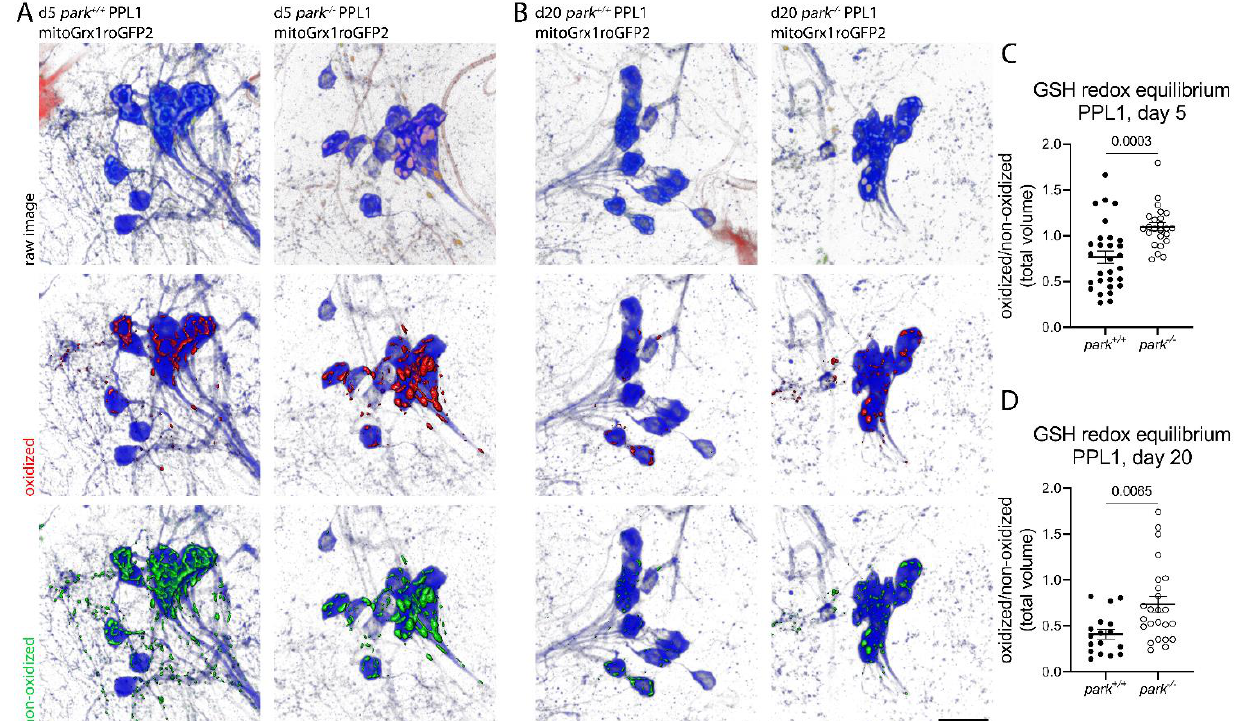
Figure 2. Parkin-null Drosophila have increased PPL1 mitochondrial glutathione redox equilibrium. Brains were dissected from control ( park +/+ ) or parkin-null ( park −/− ) flies expressing mito-roGFP2-Grx1 on days 5 and 20 post-eclosion, and ratios of total volumes of oxidized to non-oxidized fluorophore emissions were calculated for one PPL1 region per brain. Representative panels of days ( A ) 5 and ( B ) 20 showing raw PPL1 images (top row, where blue indicates tyrosine hydroxylase antibody labeling, and red and green indicate oxidized and non-oxidized roGFP2, respectively). Selected volume “isosurfaces” of oxidized (red, middle row) and non-oxidized (green, bottom row) mito-roGFP2-Grx1 above threshold are also shown. Scale bar, 10 µm. ( C , D ) Each data point represents the ratio from one PPL1 region ( n ≥ 17). Unpaired t tests were performed to determine the effect of genotype on days 5 and 20, respectively. Error bars represent standard error of the mean, and p values are reported for each comparison.